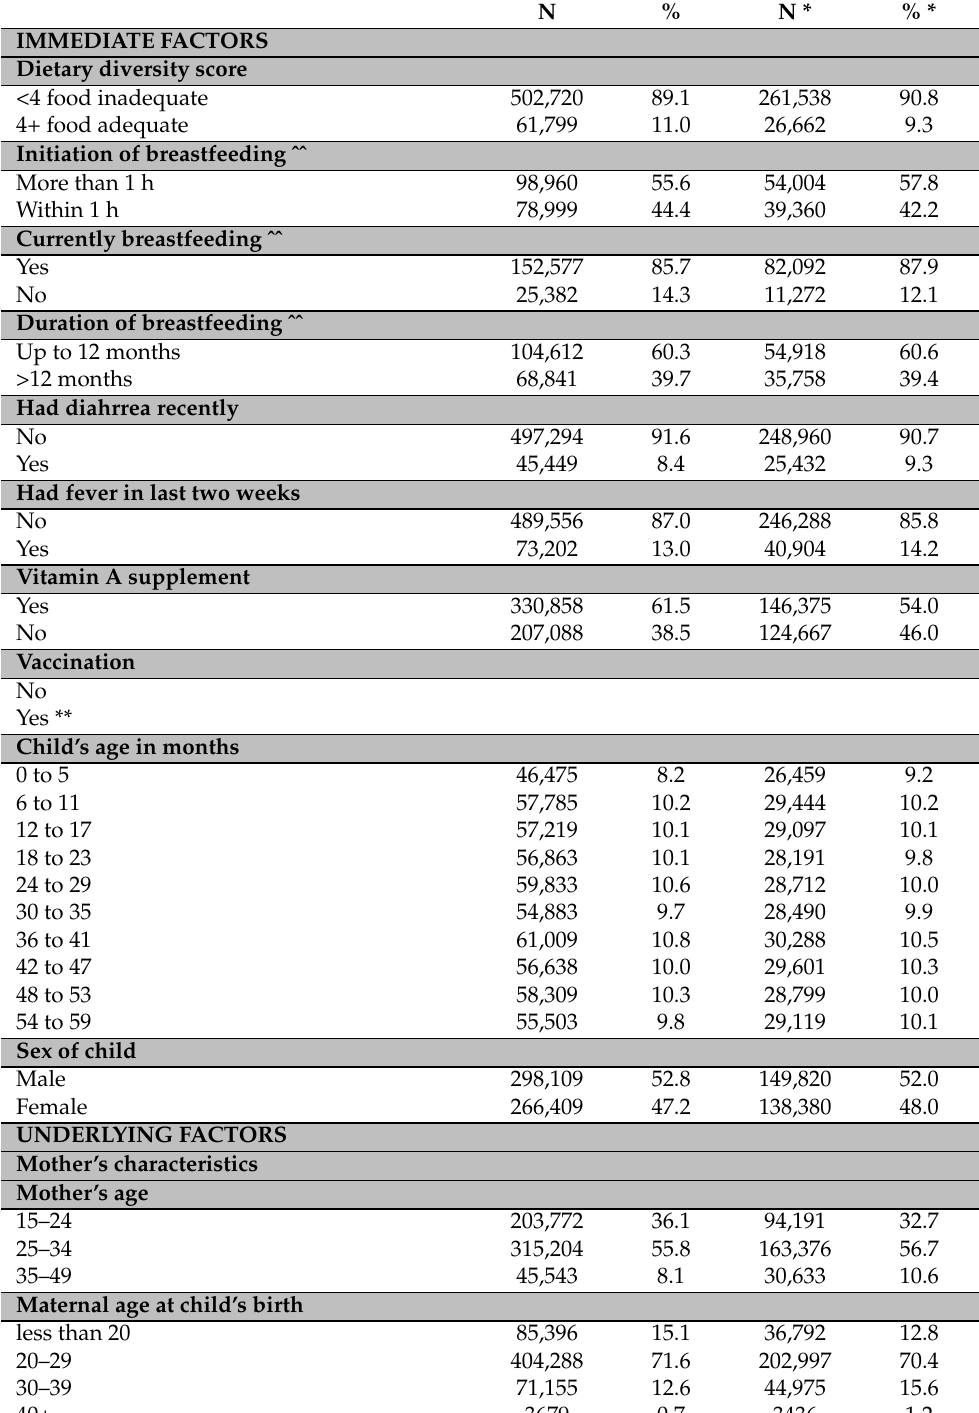
Table 1. Characteristics of parents and children aged 0–59 months in five South Asia countries